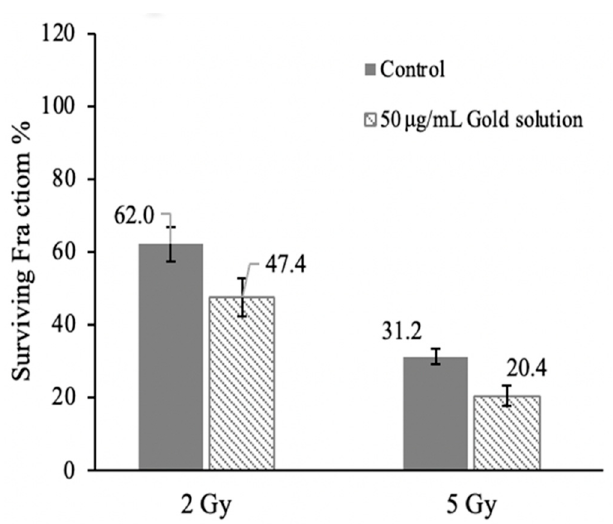
Figure 11. Surviving fraction of 9LGS cells untreated and treated with 50 µ g/mL of AuNP suspension, irradiated at 2 and 5 Gy 125 kVp compared to control cells. Treatment populations were normalized to their respective unirradiated treated data.